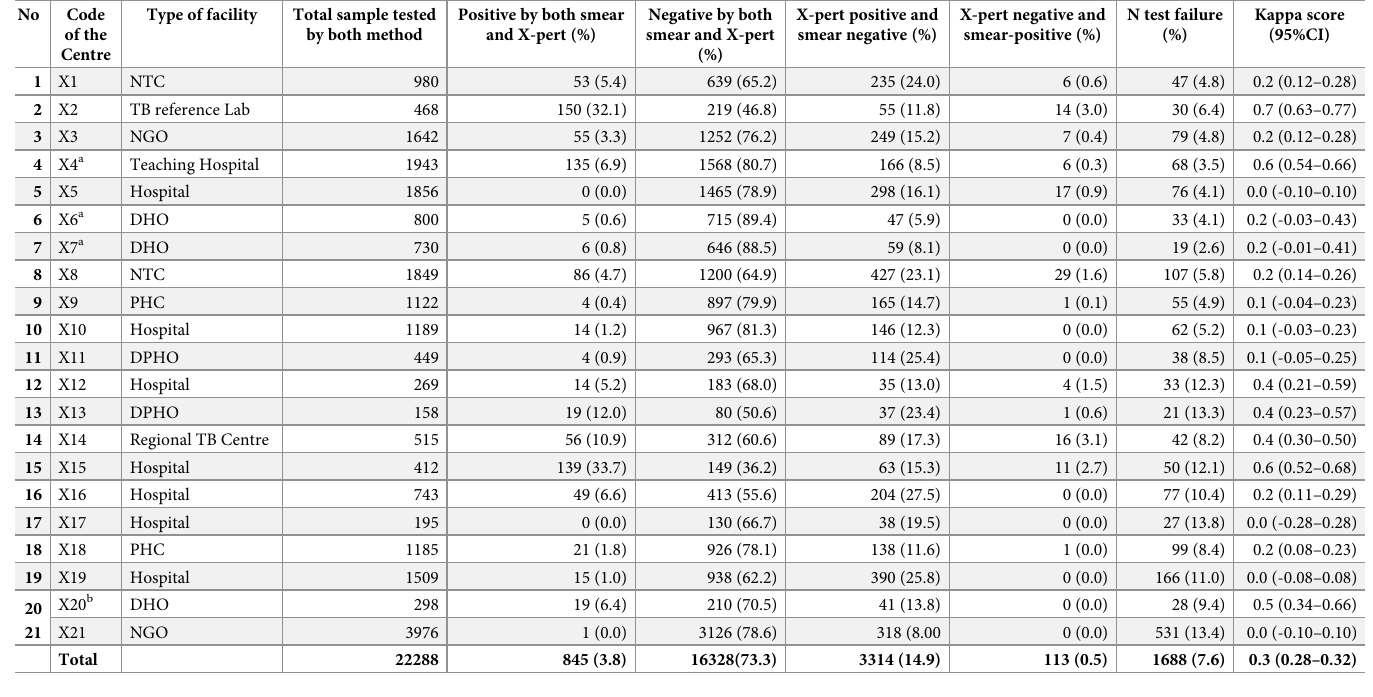
Table 2. Gene X-pert MTB/RIF and Microscopy results by testing centres in Nepal, 2015–2016.